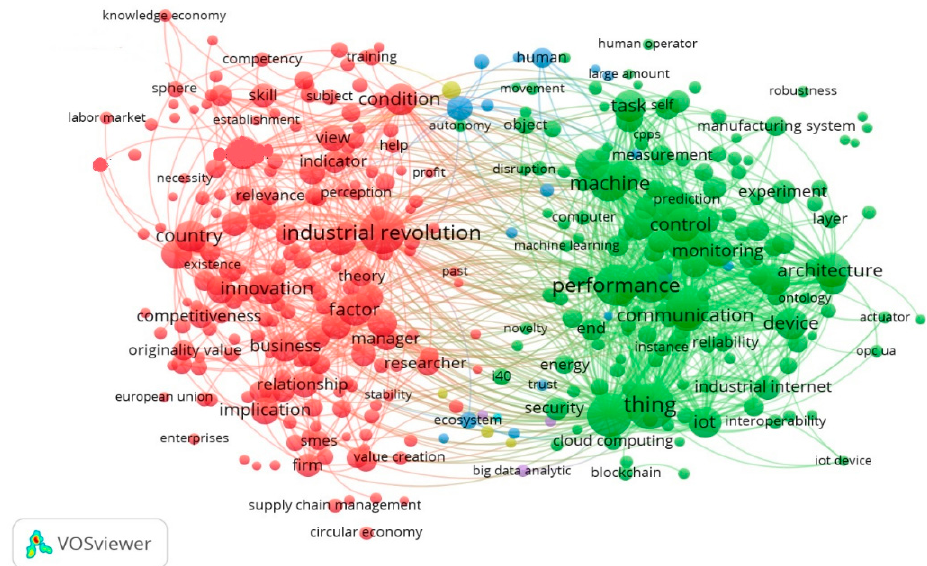
Figure 2. The semantic map for analysis of Industry 4.0. Source: own study.